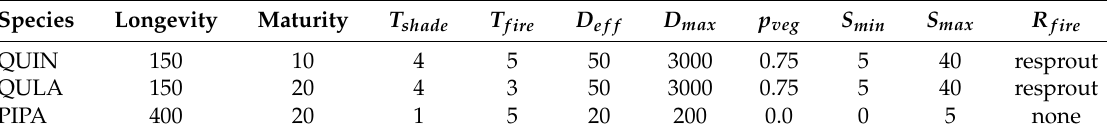
Table A30. Species